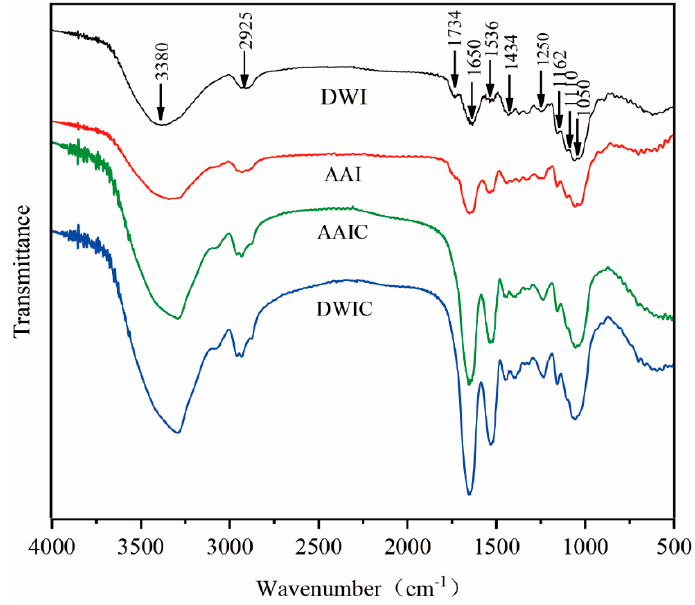
Figure 4. FT − IR spectra of alcohol-insoluble residue (AIR) from different treatment groups in the region of 4000–500 cm − 1 . DWI: distilled water immersion for 15 h; AAI: 0.6% acetic acid immersion for 15 h; DWIC: cooked DWI; AAIC: cooked AAI.